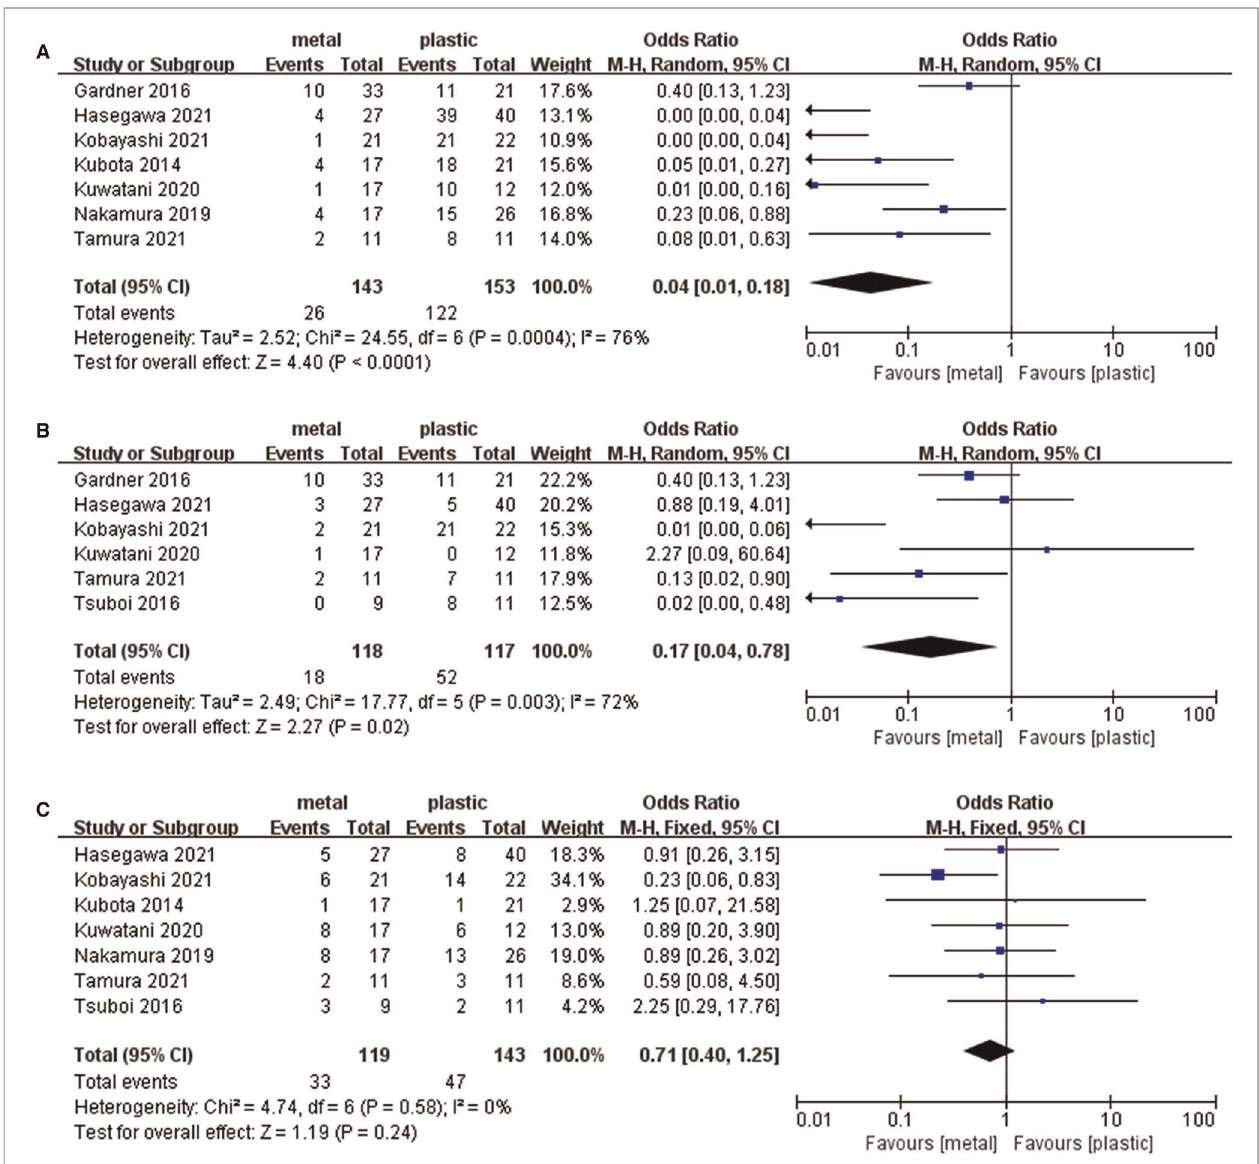
FIGURE 3 | Forest plot of ( A ) Rate of endoscopic reintervention; ( B ) Rate of stent-related complications; ( C ) Rate of overall postoperative